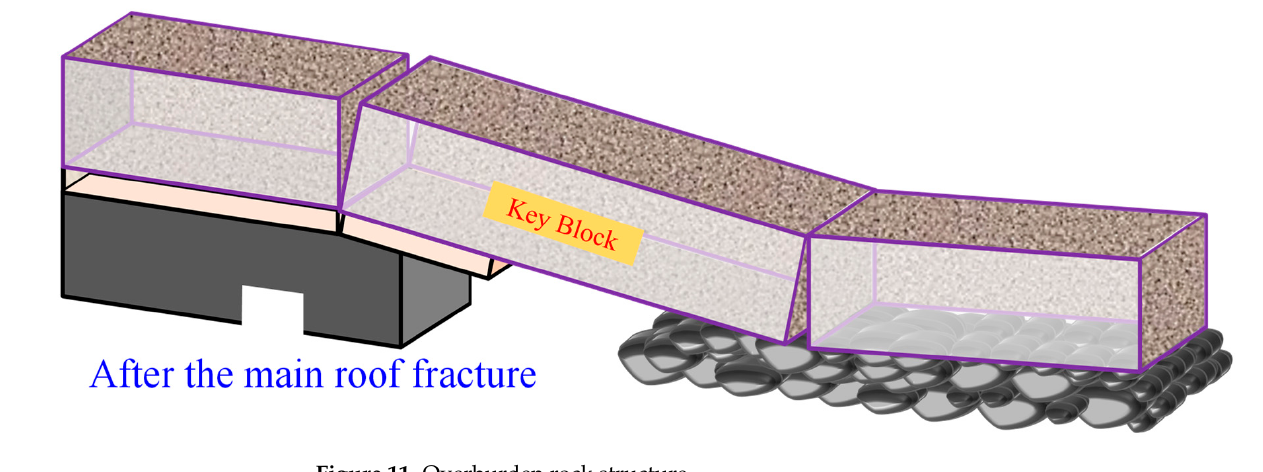
Figure 11. Overburden rock structure.